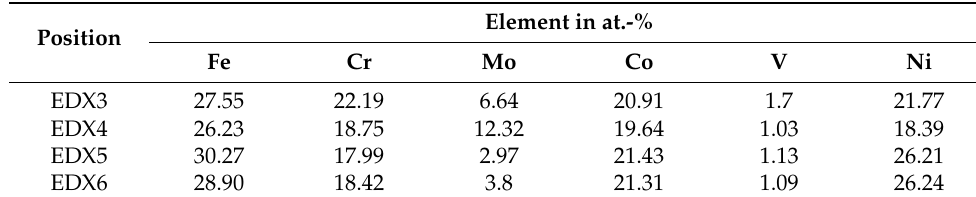
Table 5. Chemical composition of the used HEA in advance of casting (EDX).